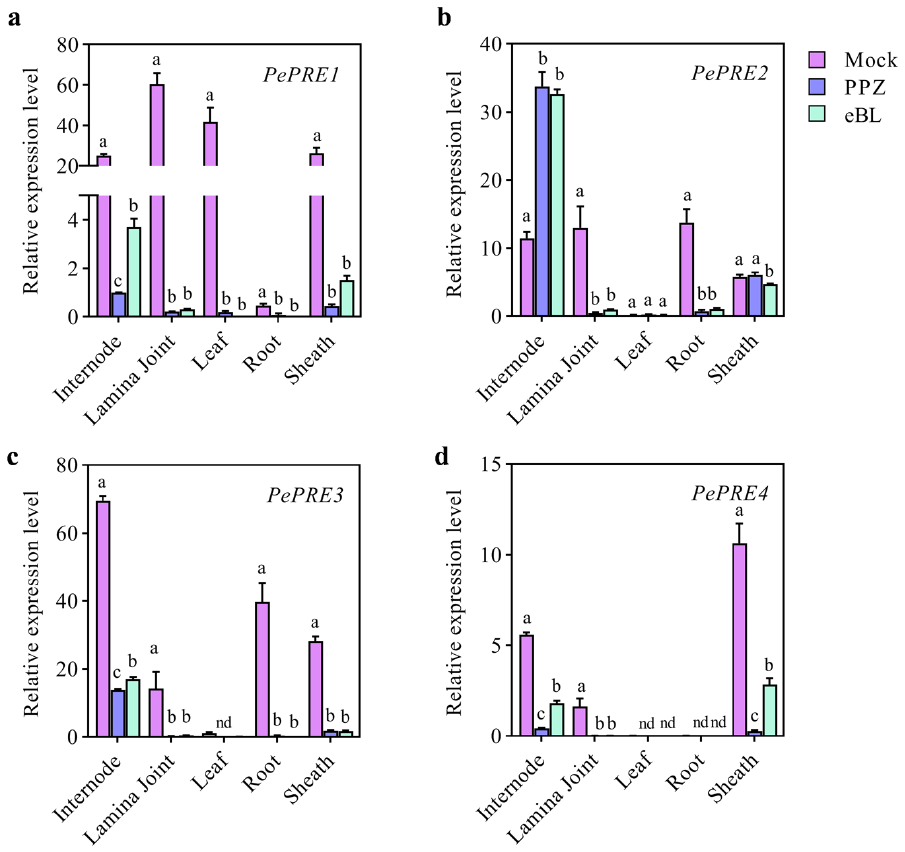
Figure 5. The expression levels of PePRE s after eBL or PPZ treatment in bamboo seedlings. Quantita- tive RT-PCR analysis of PePRE s ( a – d ) in different bamboo seedling organs after PPZ or eBL treatment. The bamboo seedlings were grown on half MS medium for 18 days. For PPZ treatment, plants were transferred to half MS medium containing 50 µ M PPZ for another 4 days. For eBL treatment, the seedlings were transferred to half MS medium containing 10 µ M PPZ and 1 µ M eBL solution for 4 h. Different lowercase letters above the data columns indicate significant differences ( p < 0.05; Duncan’s test); nd, no data available.